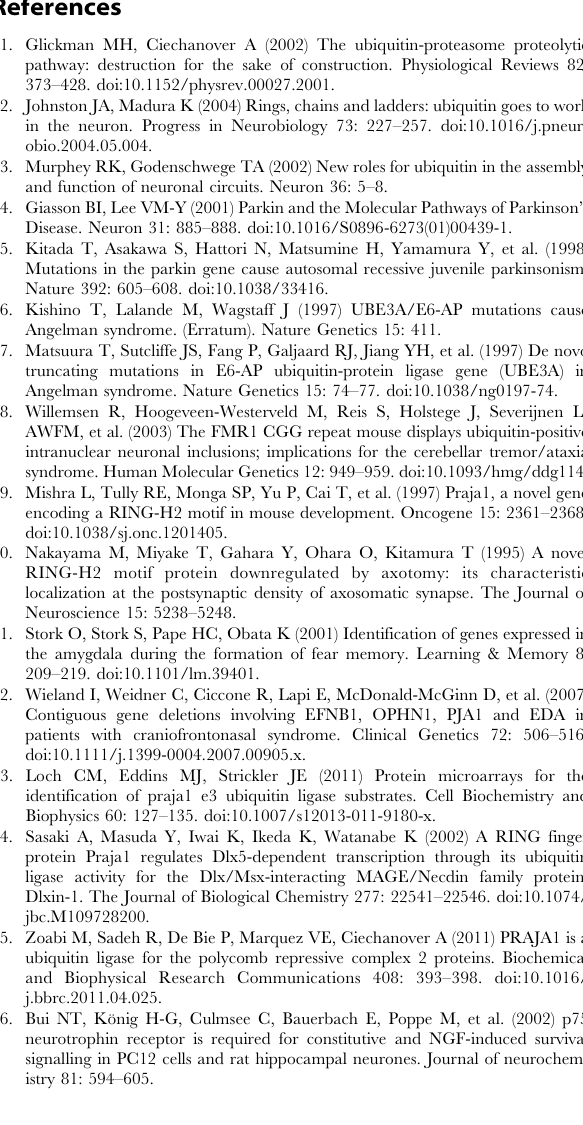
Figure S5 Induction of apoptosis in COS-7 cells through Praja1 expression. (A) COS-7 cells acutely transfected with praja1.1 or praja1.2 display cell rounding and microspike formation (arrow), and develop pyknotic nuclei, indicating an induction of apoptosis. EGFP and HA fusion proteins are equally effective in inducing this phenotype (data not shown), whereas transfection with control vectors has no such effect. (B) Quantitative analysis of cell morphology indicates differences in the effectiveness of Praja1 isoforms to induce this change. On the one hand, cell rounding is similarly induced by EGFP::Praja1.1/2 (cell size 410 + / 2 235 m m 2 , 14.3% spreading cells) and EGFP::Praja1.2 (cell size 245 + / 2 115 m m 2 , 18.2% spreading cell), as compared to EGFP transfected controls (cell size 660 + / 2 459 m m 2 , 53.9% spreading cells) or non-transfected cells within the samples (cell size 909- 1071 m m 2 , 82.2%–89.8% spreading cells). On the other hand, the incidence of microspike formation decreases from combined overexpression of EGFP::Praja1.1 and EGFP::Praja1.2